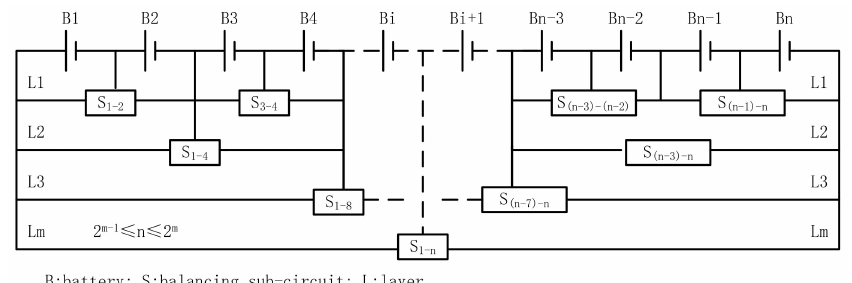
Figure 1. The parallel architecture equalizer proposed in